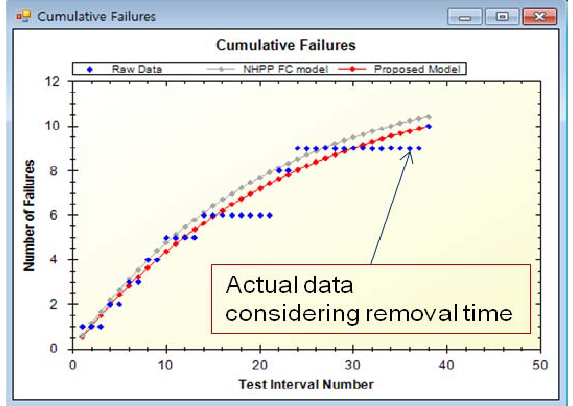
Fig. 11. Estimation Values and Actual Collected Values